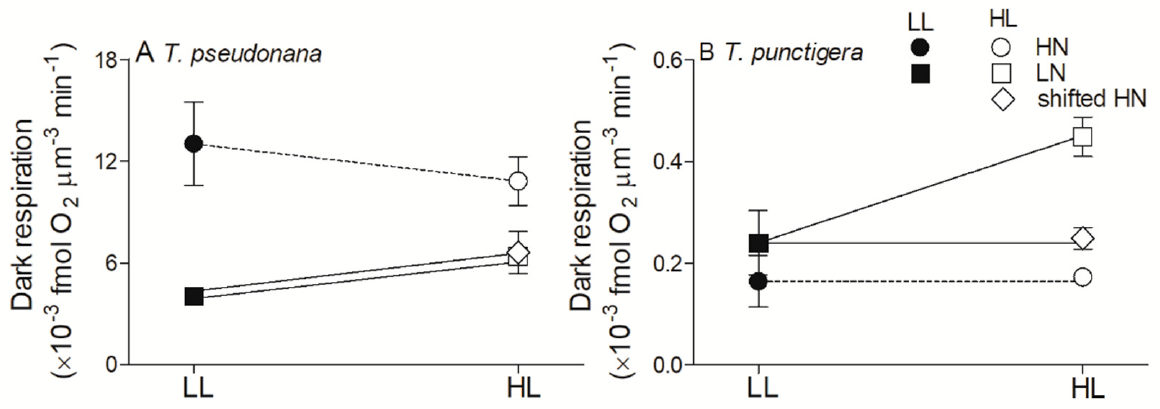
Figure 5. Cell biovolume-based dark respiration rate (fmol O 2 μ m − 3 min − 1 ) of small T. pseudonana ( A ) and large T. punctigera ( B ) grown under low or shifted-high lights, and under low and high/shifted-high nitrogen conditions. Points show averages of measurements on three independently grown cultures, and error bars show the standard deviations ( n = 3), often within symbols.